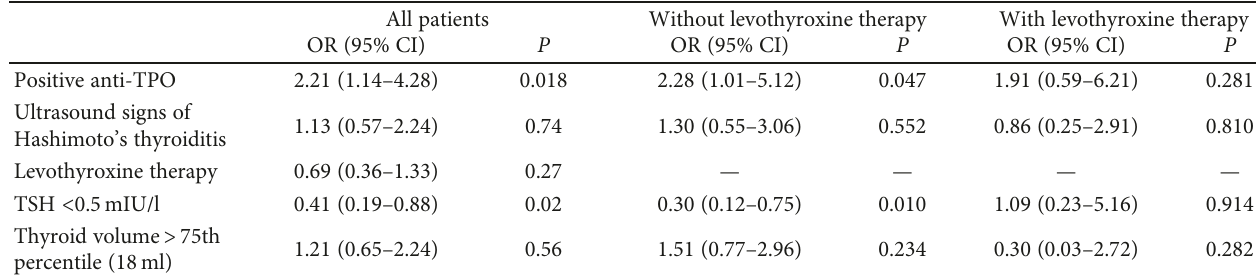
Table 3: Results of multivariate